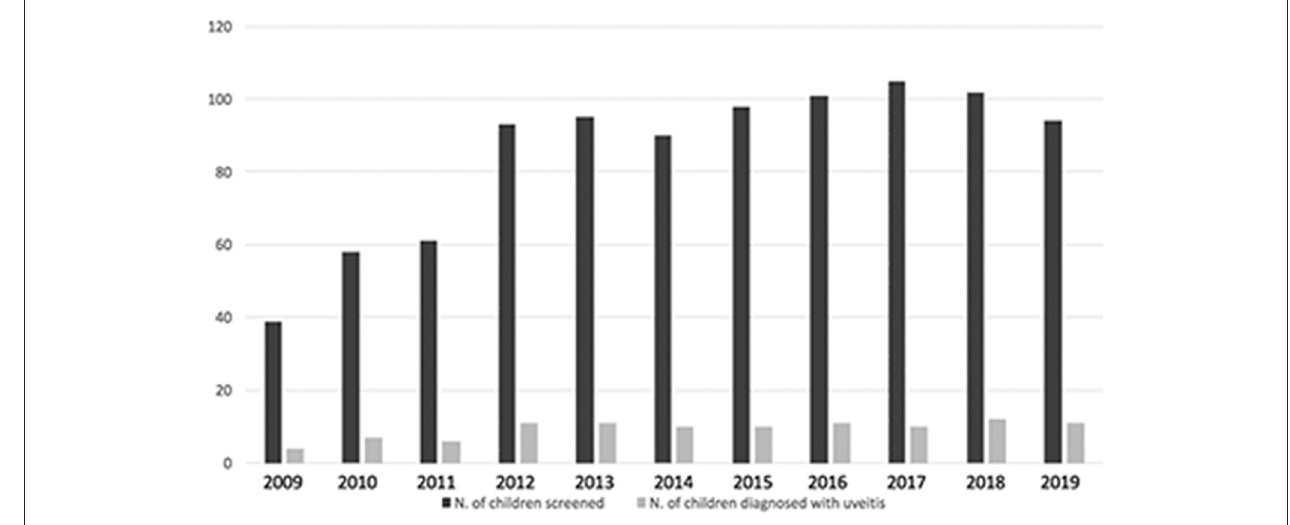
FIGURE 1 | Bar graph showing distribution of patients with JIA screened and diagnosed with uveitis during eleven-year screening period.